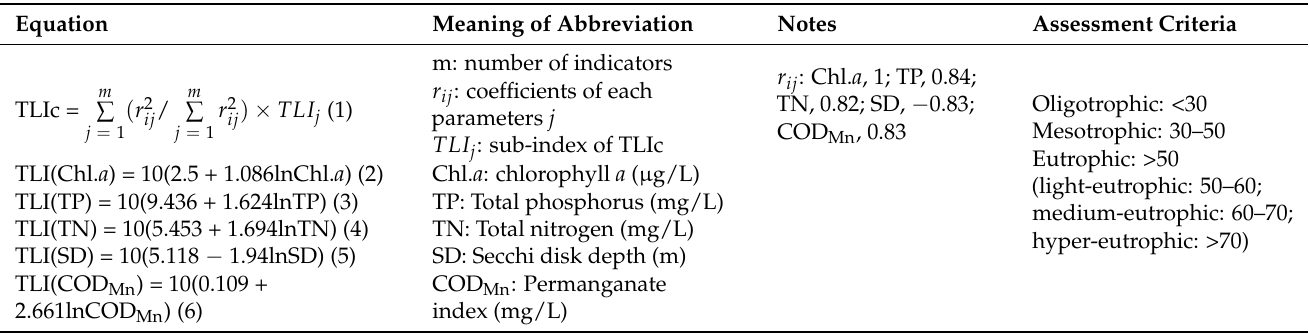
Table A2. The formulas used to calculate the comprehensive trophic level index and its assessment criteria.